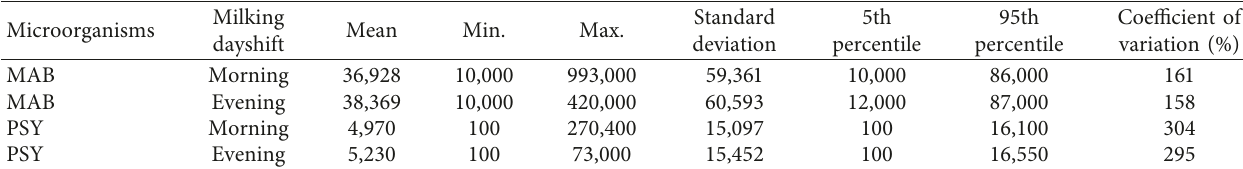
Table 2: Mesophilic aerobic bacteria (MAB, CFU/ml) and psychrotrophic bacteria (PSY, CFU/ml) counts obtained according to the milking dayshift (morning and evening).